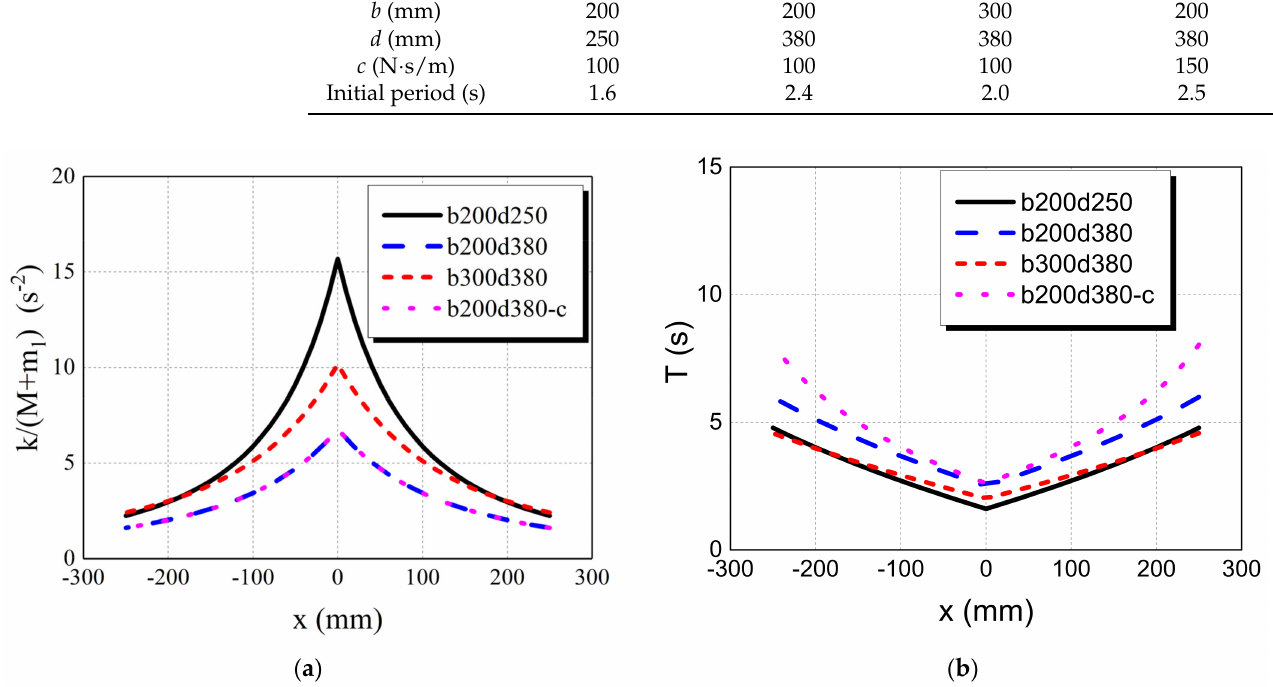
Figure 7. The stiffness comparisons with ( a ) and the natural period comparisons with ( b